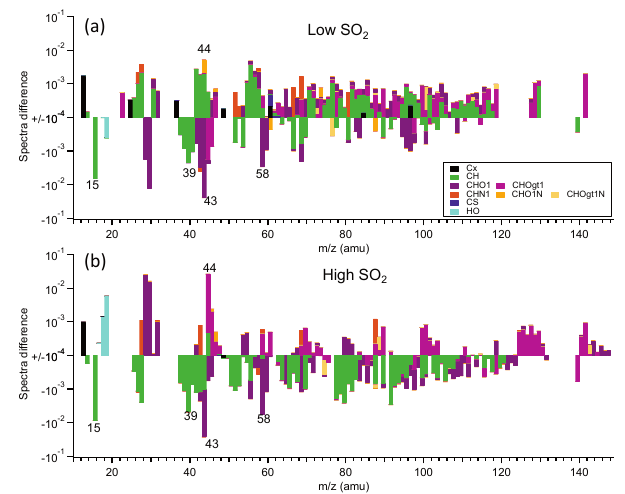
Figure 7. The difference in the mass spectra of organics of SOA from α -pinene photooxidation between high-NO x and low- NO x conditions (high NO x –low NO x ) . SOA was formed at low SO 2 (a) and high SO 2 (b) . The different chemical families of high- resolution mass peaks are stacked at each unit mass m/z (“gt1” means greater than 1). The mass spectra were normalized to the total organic signals. Note the log scale of the y axis and only the data with absolute values large than 10 − 4 are shown.